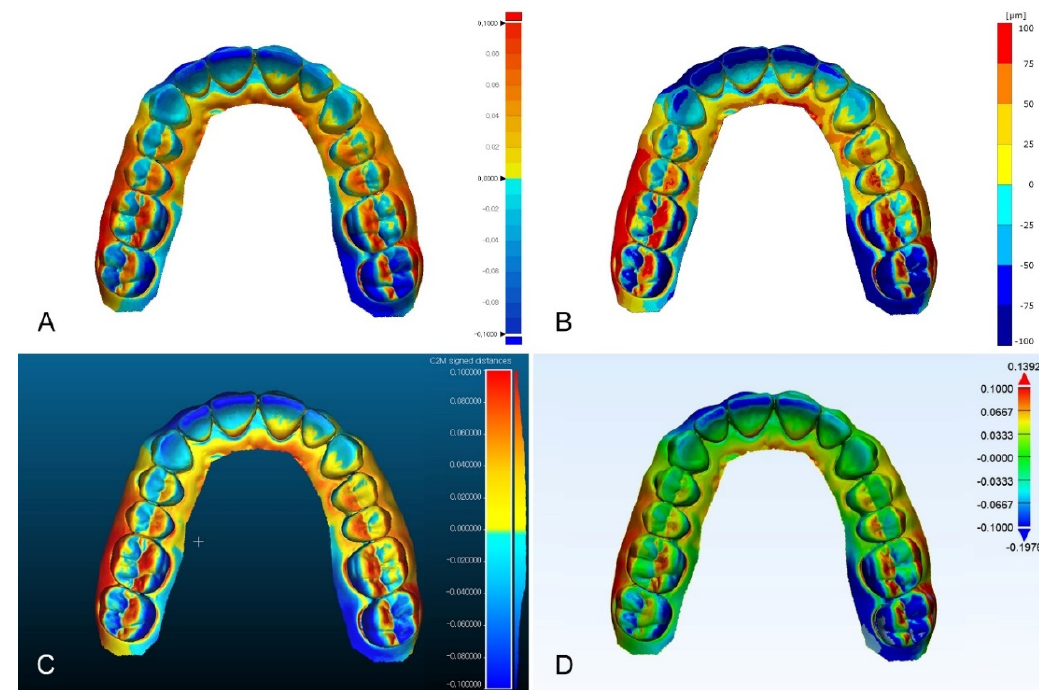
Figure 3. Comparison of color difference maps of complete-arch region evaluated by using four analysis software programs: ( A ) Geomagic control X; ( B ) GOM Inspect; ( C ) Cloudcompare; ( D ) Materialise 3-matic.